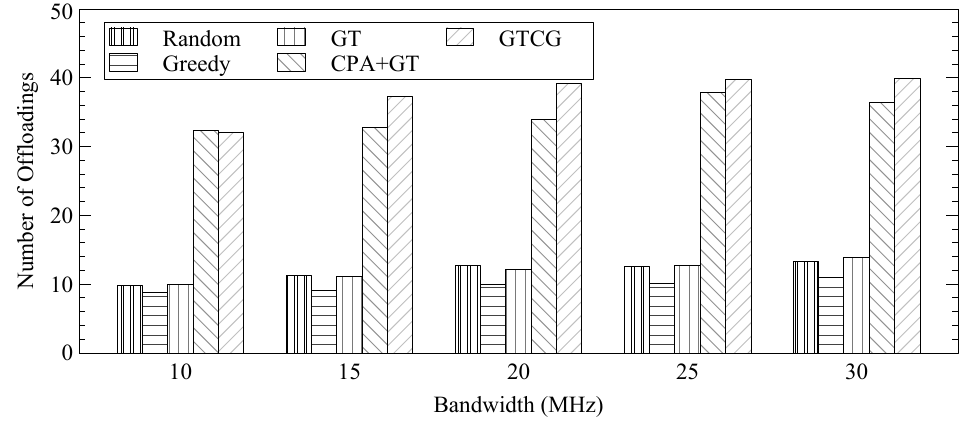
Figure 6. Average Number of Offloadings with Different Bandwidth.